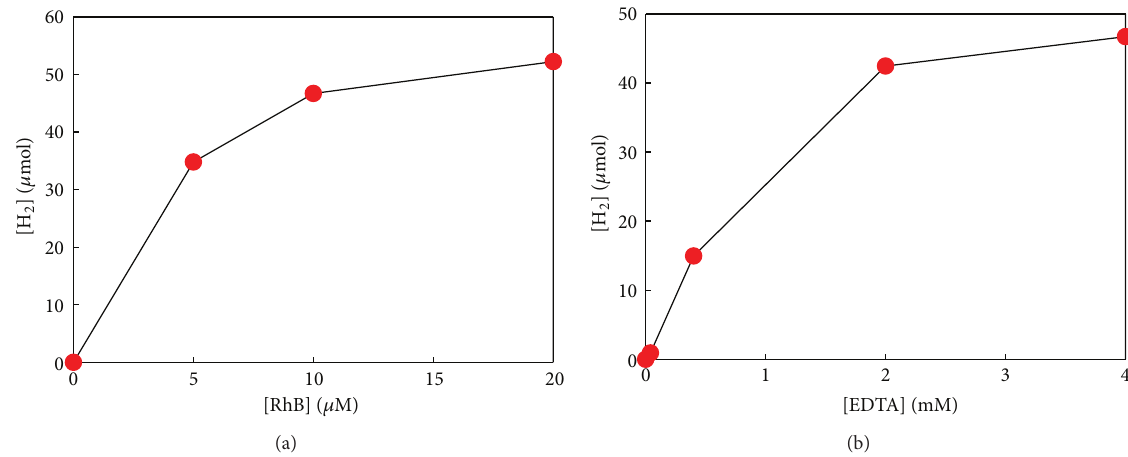
Figure 3: Time-profiled H 2 production in the suspension of Pt/TiO 2 /Nf as a function of (a) RhB and (b) EDTA concentration. Experimental conditions: [catalyst] = 0.5 g L −1 , [EDTA] = 4mM (for part (a)), [RhB] = 10 𝜇 M (for part (b)), pH 𝑖 = 2.3 , and 𝜆 > 420 nm.